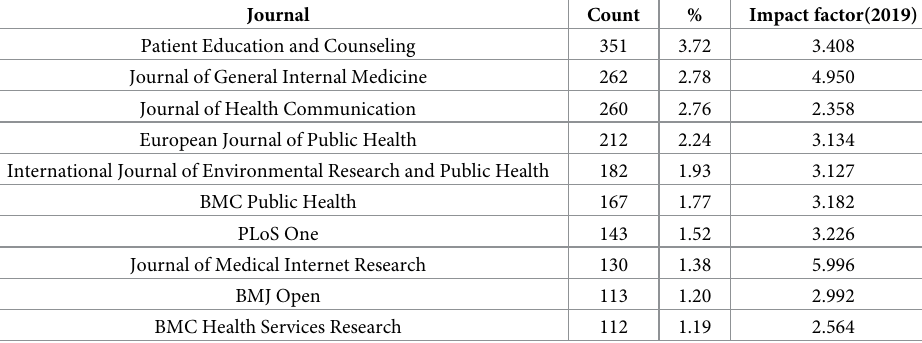
Table 2. Top 10 most prolific journals of health